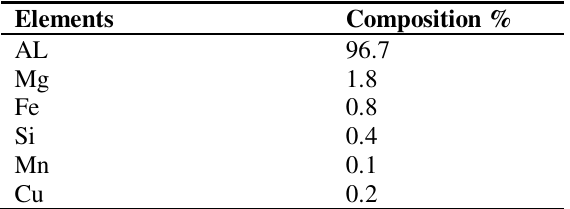
Chemical Composition of (Al) Alloy Grade 5050 .